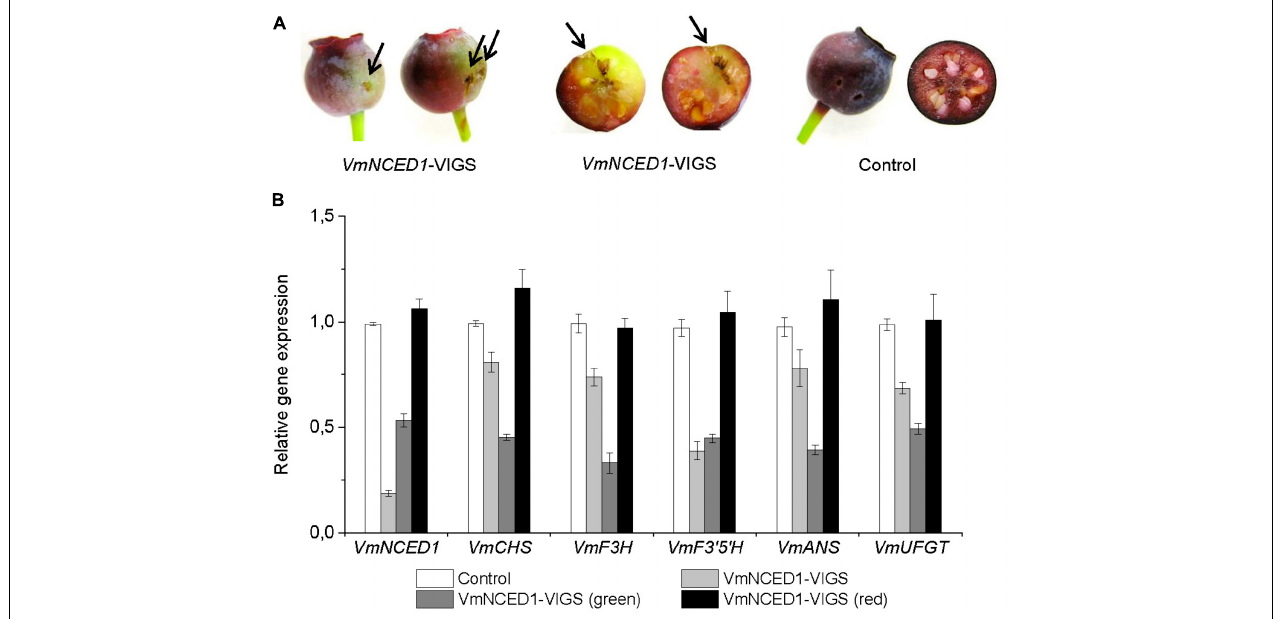
FIGURE 6 | Effect of VmNCED1 silencing on anthocyanin biosynthesis in ripening bilberry fruit. Green unripe fruits still attached to the bilberry plants were injected with VmNCED1 -VIGS vector or pBINTRA6 vector only (control). Arrows indicate injection sites. Fruits were evaluated 4 weeks after injection for color (A) , and the expression of VmNCED1 and the key anthocyanin biosynthetic genes in intact fruits as well as in green and red sectors of chimeric fruits (B) . Relative expression of the genes was quantified by qRT-PCR and normalized to VmGAPDH . Values represent means ± SDs of three